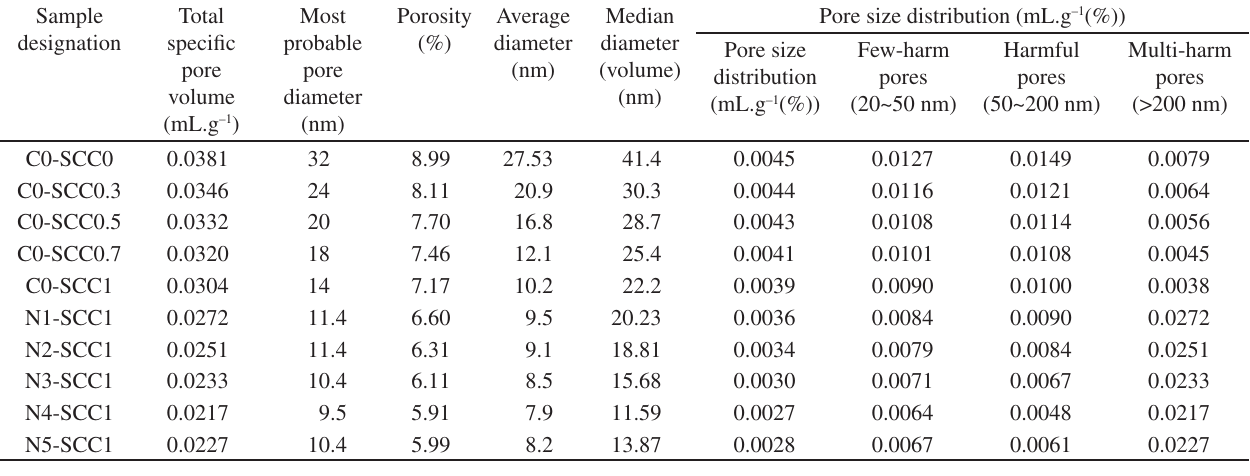
Table 5. Properties of the pores in C0-SCC and N-SCC specimens. Sample